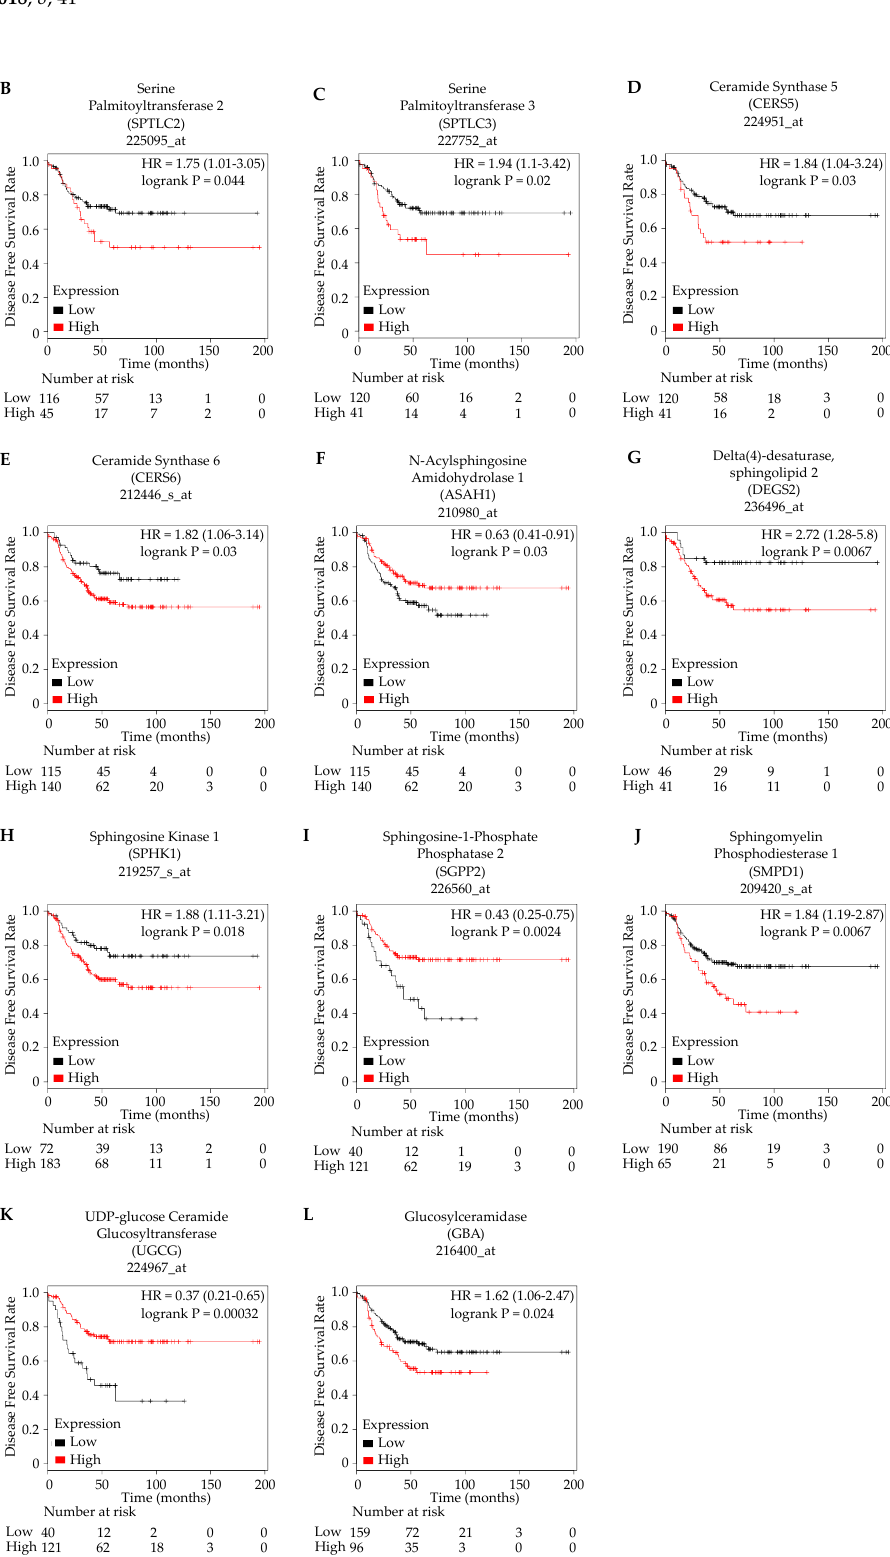
Figure 3. Survival analysis of TNBC patients based on the gene expression of enzymes involved in sphingolipid metabolism. ( A ) Pathway diagram depicting the association of altered enzyme expression involved in sphingolipid metabolism and its effect on disease-free survival outcome. ( B ) SPTLC2, ( C ) SPTLC3, ( D , E ) CERS5, CERS6, ( F ) ASAH1, ( G ) DEGS2, ( H ) SPHK1, ( I ) SGPP2, ( J ) SMPD1, ( K ) UGCG, and ( L ) GBA gene expression were determined to be associated with disease-free